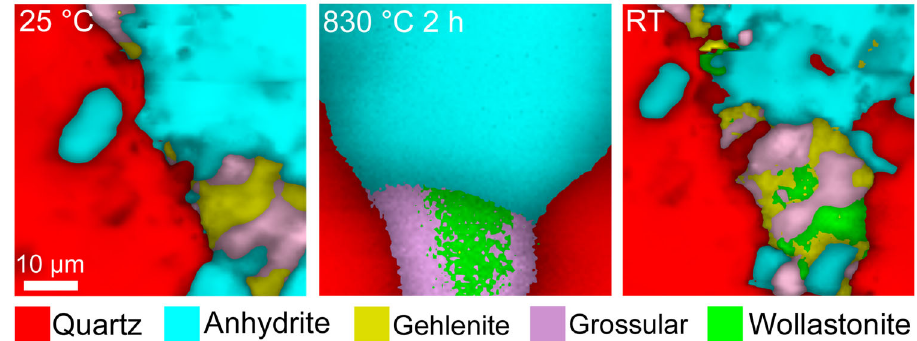
Fig. 8 Normalized false-color hyperspectral Raman images of the in situ experiment AQG-1. (Note that at 830 ± 5 (cid:3) C wollastonite partly replaced gehlenite and grossular, the latter being an impurity in the natural gehlenite crystal used for the